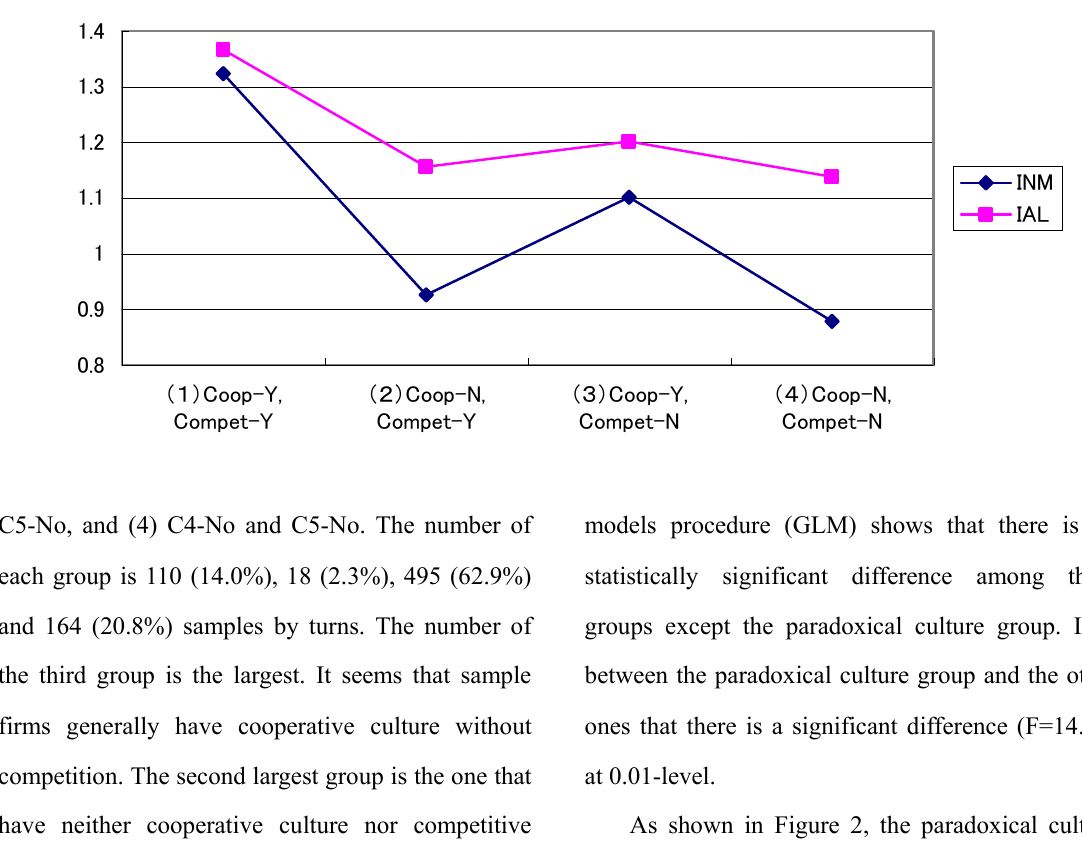
Figure 2. The Comparison of INM & IAL Score Between Four